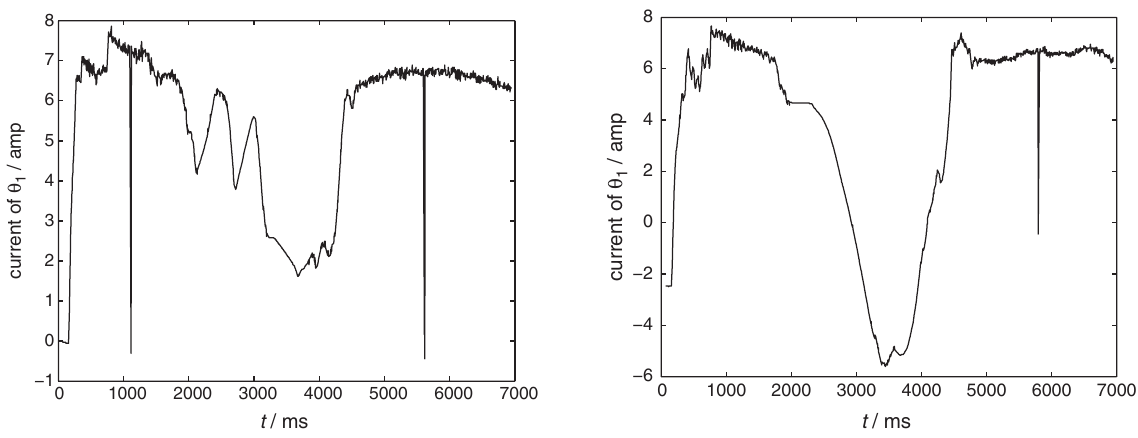
Fig. 10. Current of joint 1 using interpolation. Fig. 11. Current of joint 1 using